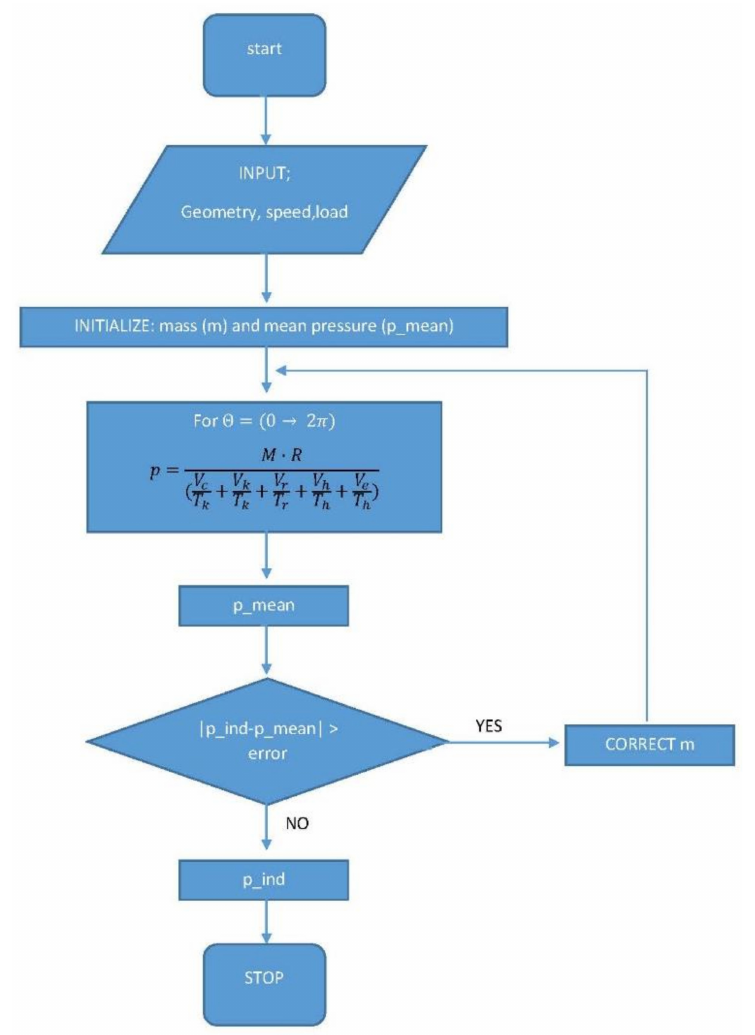
Figure 7. Flow diagram of the isothermal model.